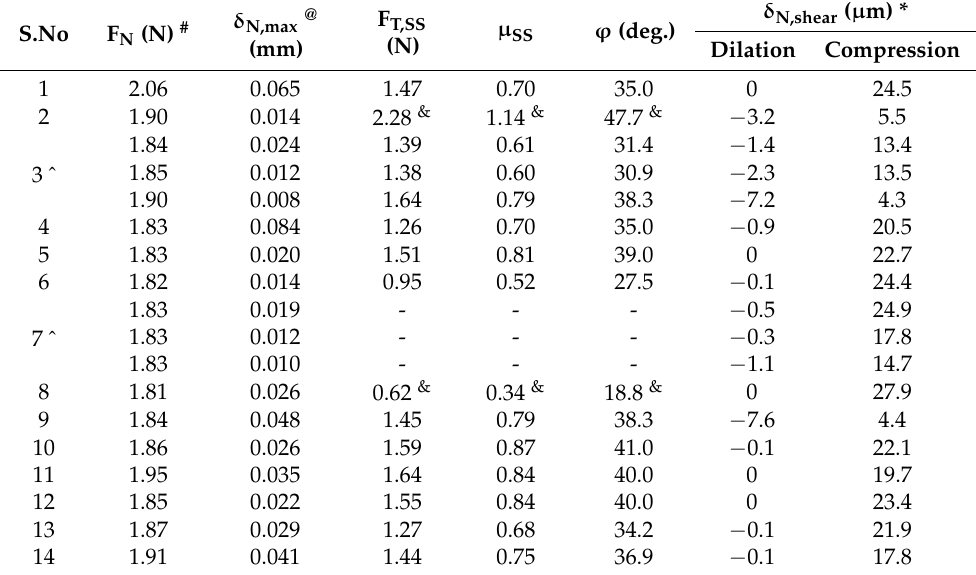
Table 2. Testing details and preliminary